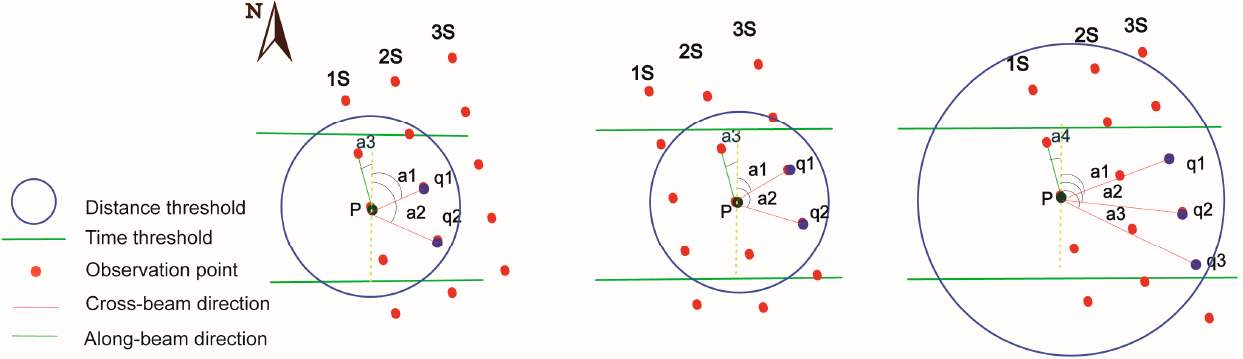
Figure 4. Schematic diagram of calculation method for the cross-beam DOV (‘a1’, ‘a2’ and ‘a3’ is the azimuth of two adjacent observation points).